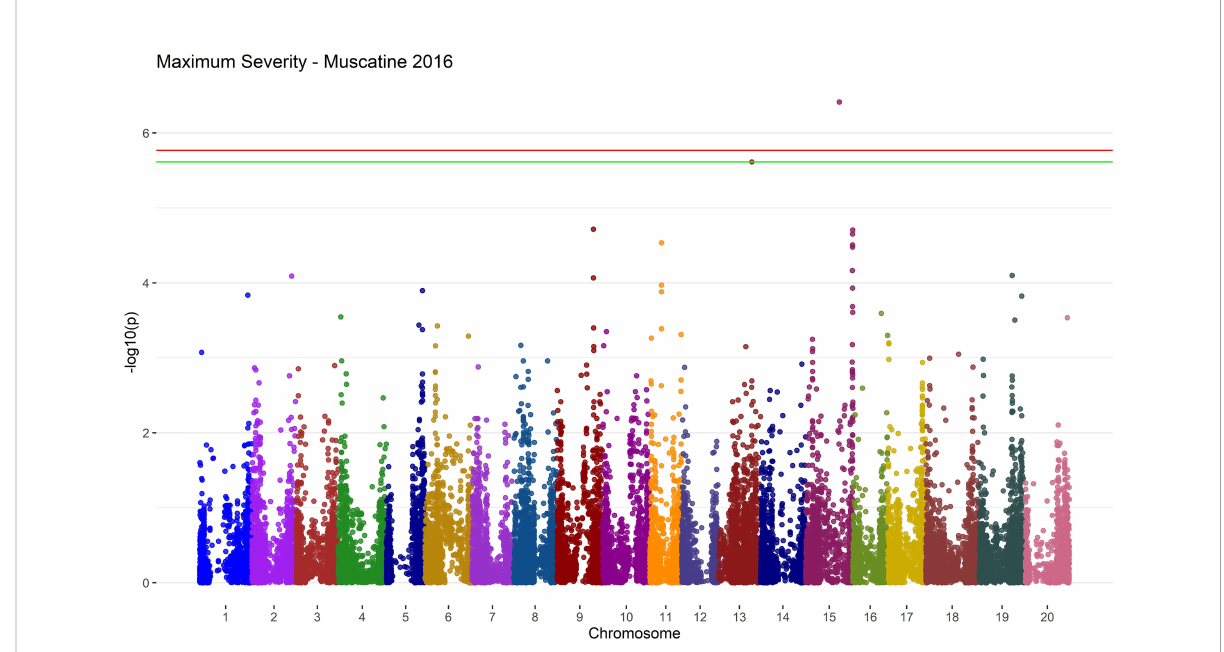
FIGURE 8 Manhattan plot of results from MLM in Tassel 5 for the Maximum Severity trait in Muscatine 2016 using a MAF of 5%. The negative log base 10 transformed p values are plotted against their position along each of the 20 chromosomes. The green line represents the FDR correction threshold and the red line represents the Bonferroni correction threshold. Signi fi cant SNPs are denoted by exceeding the FDR correction threshold. In this environment/trait combination, run with the MLM model on Tassel 5, there are two signi fi cant SNPs, one on chromosome 13 and the other on chromosome